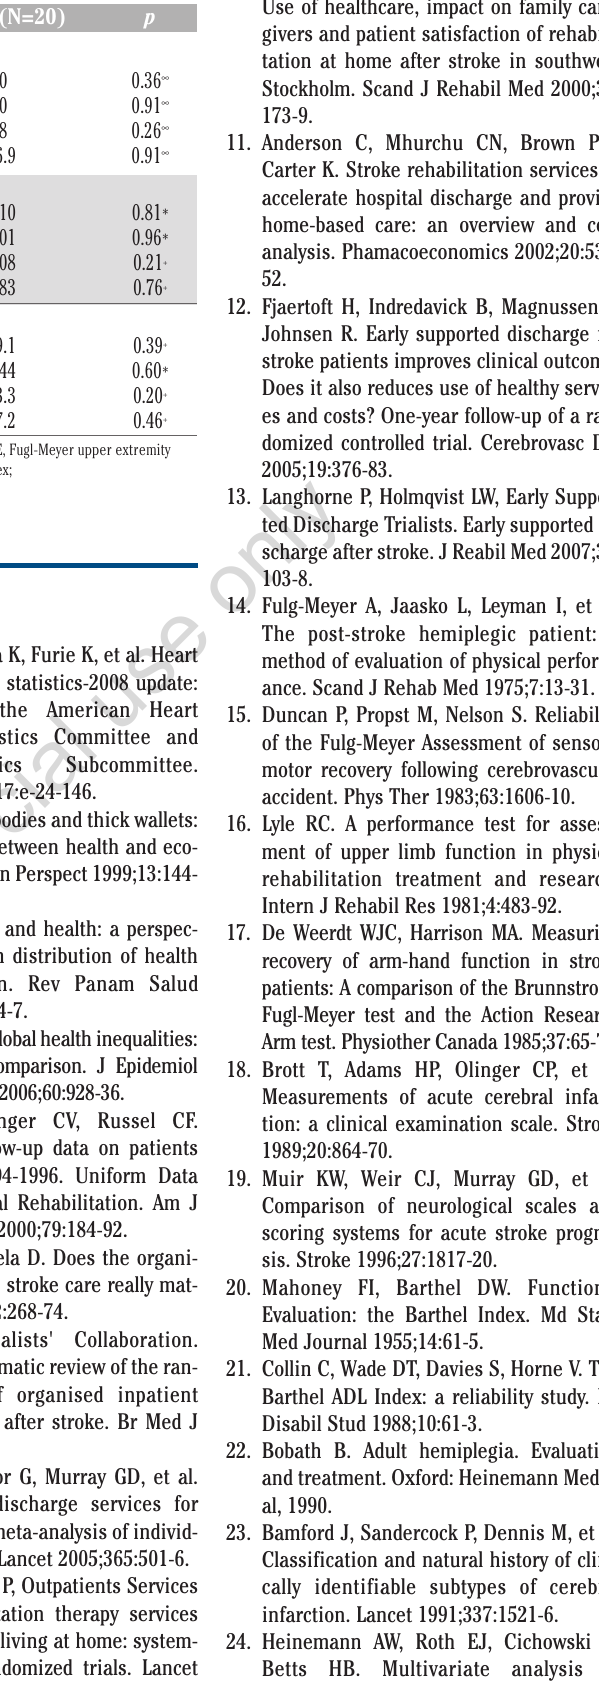
Table 4. Changes of the outcome measures among the inpatient (U.S.) and outpatient (Brazil) rehabilitation